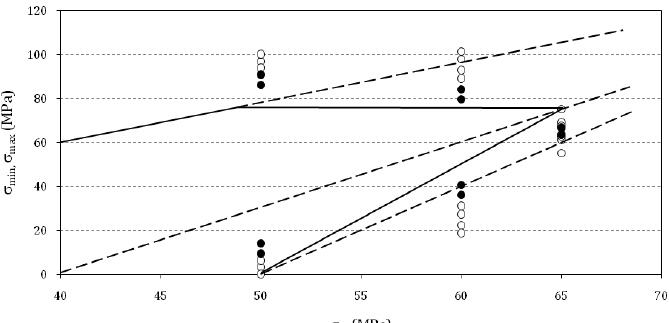
Figure 13: Goodman-Smith diagram of tensile fatigue test results. Failed specimens are indicated with white dots and non-failed specimens with black dots; trend lines are also